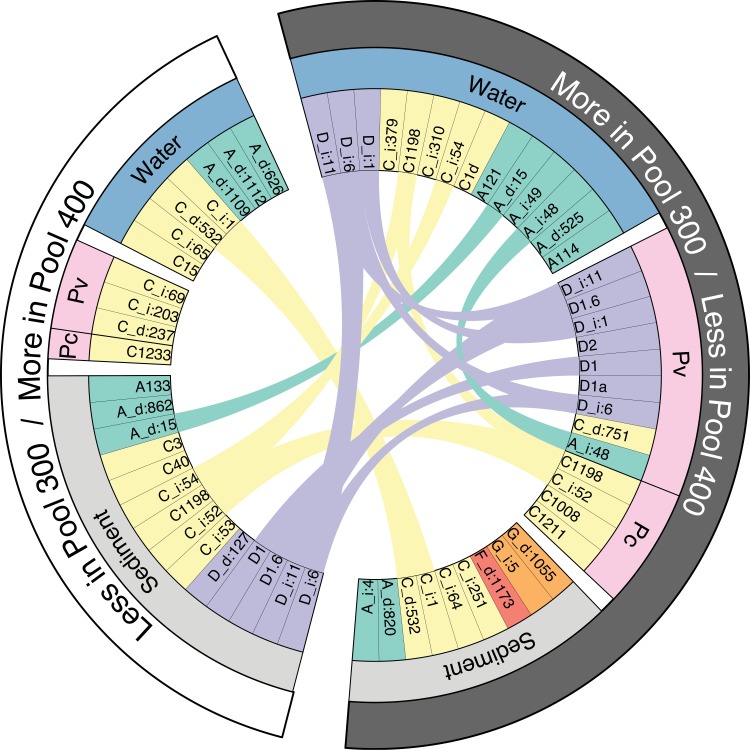
Altered compartmental distributions of Symbiodinium between pools.The inner ring shows Symbiodinium taxa (clade A = green, C = yellow, D = purple, F = red, G = orange) that were differentially abundant in each compartment (middle ring: water = blue, sediment = gray, coral = pink, Pavona venosa = Pv, Psammocora contigua = Pc) between pools. The outer ring indicates whether taxa were more or less abundant in each pool, and ribbons connect instances where taxa were differentially abundant in multiple compartments. Ribbons reveal different compartmental distributions of taxa in each pool: in pool 300 (vs. 400), 8 taxa (including 4 clade D) were less abundant in sediments and more abundant in water and/or coral, while 2 other clade C taxa were more abundant in sediments and less abundant in water.